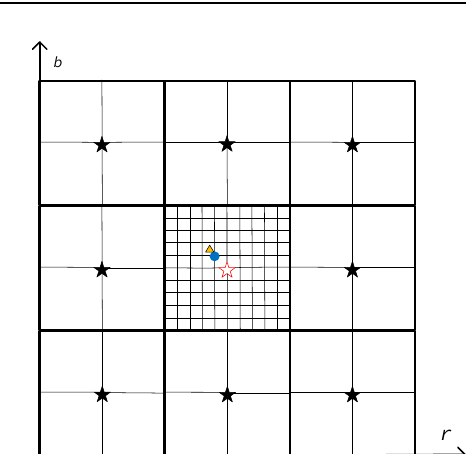
Figure 6. For simplicity of drawing, C ( x ) is a two dimensional matrix and k equals to 3. c t ( x ) is ( x ) is indicated by a hollow red pentagram the cell of the target x indicated by a orange triangle, c i 0 in the center closest to c t ( x ) , C ( x ) is the measurement cell set indicated by all pentagrams which is ( x ) in each dimension and c t ( ˜x ) is indicated by an blue dot which the nearest 3 cells around cell c i 0 approximates c t ( x )